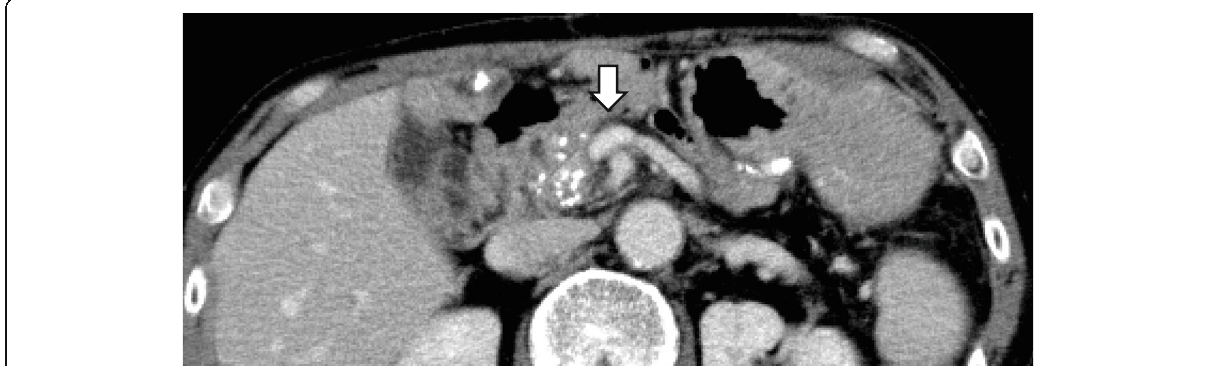
Fig. 6 Findings of enhanced CT 3 years after surgery. The stenosis of the portal vein was